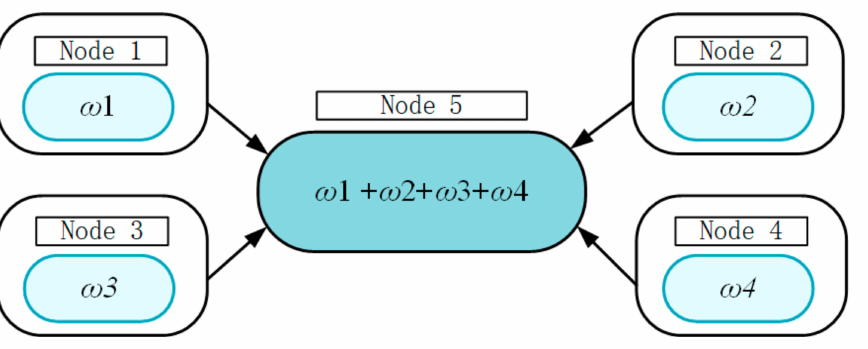
Figure 4. Calculation of node